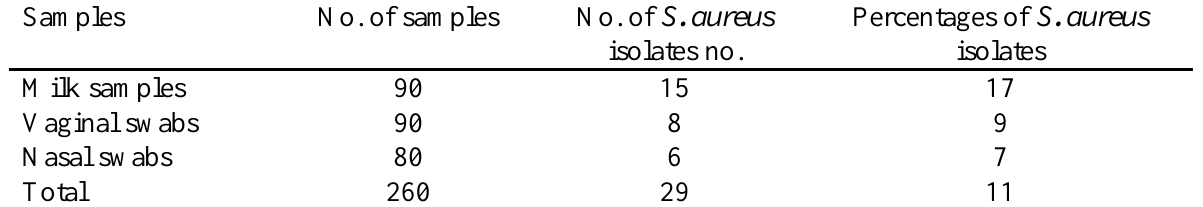
Table 3: Incidence of S. aureus in cow milk samples and dog nasal and vaginal swabs Samples